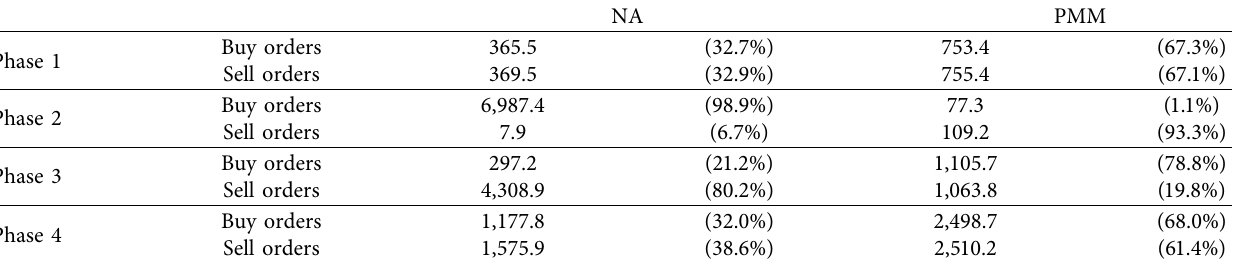
Table 5: Numbers and proportions of NA’s orders and PrOMM’s orders in the order book that matched a new order.